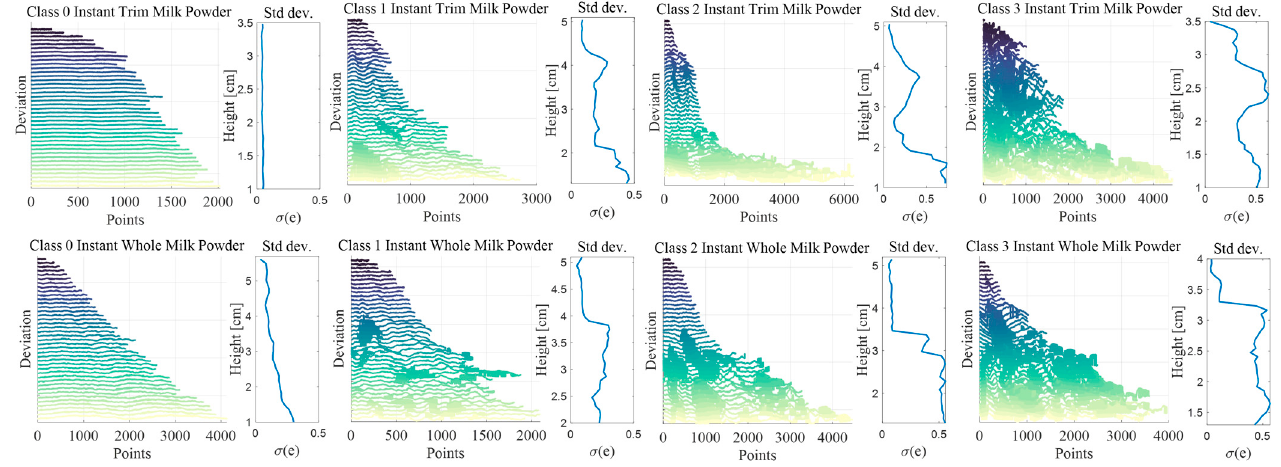
Figure 11. The deviations and the standard deviation of Class 0–3 instant whole and trim milk pow ‐ der